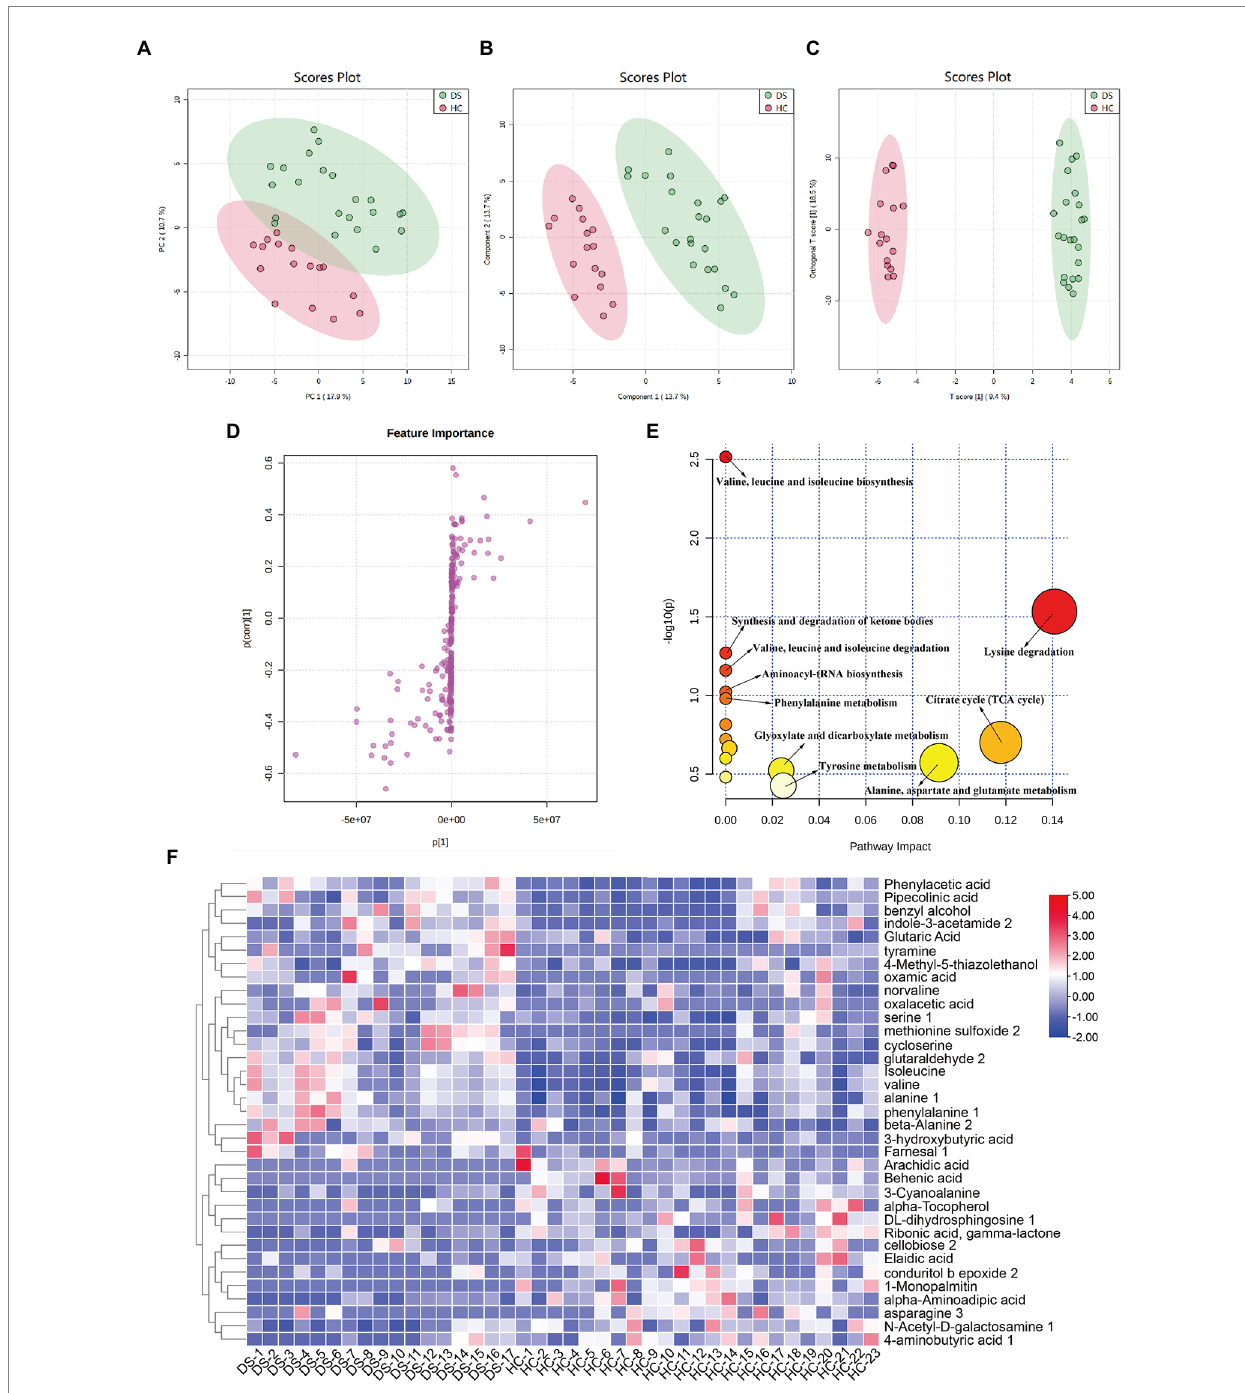
FIGURE 5 Differences in fecal metabolomic profiles and pathways in individuals with DS and non-DS volunteers. (A) Fecal metabolomic profiling by GC-TOF-MS. PCA score plot for the non-DS and DS groups. (B) PLS-DA score plot for the non-DS and DS groups. (C) OPLS-DA score plot for the non-DS and DS groups. (D) S-loading plot based on the OPLS-DA analysis of fecal metabolomics. (E) Heatmap of the relative abundance of significantly different metabolites (VIP > 1.0 and p < 0.05) between the non-DS (HC) and DS groups. (F) Metabolic pathway impact prediction based on the KEGG online database. The -ln( p ) values from the pathway enrichment analysis are indicated on the horizontal axis, and the impact values are indicated on the vertical axis. HC, non-DS volunteer (or non-DS group); DS, individual with DS (or DS